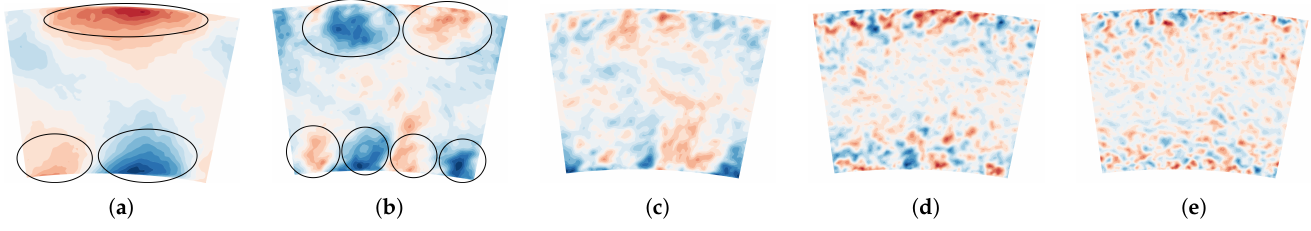
Figure 7. First mode for temperature. ( a ) 500 Hz. ( b ) 1000 Hz. ( c ) 1500 Hz. ( d ) 5000 Hz. ( e ) 8000 Hz.